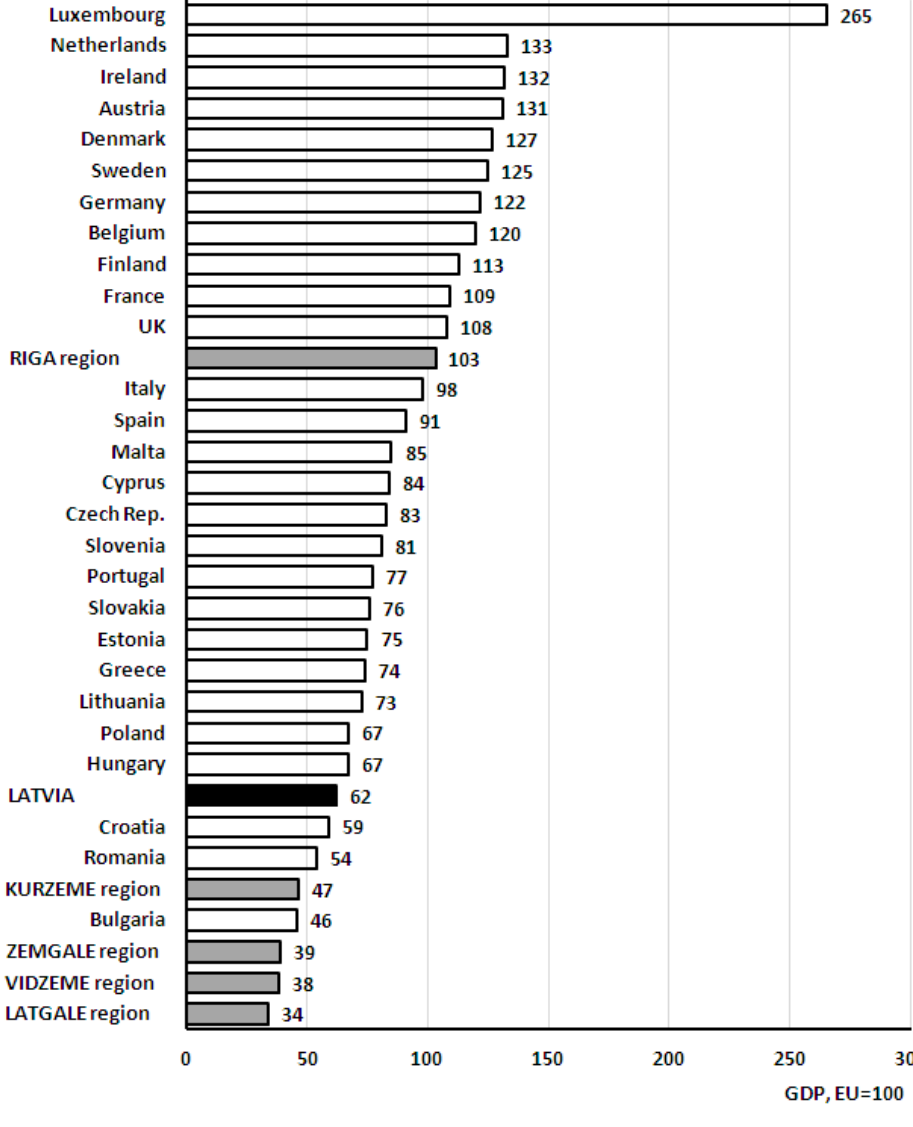
Fig. 1. GDP per capita in PPS in 2014 (EU=100) Source: Central Statistical Bureau of Latvia;